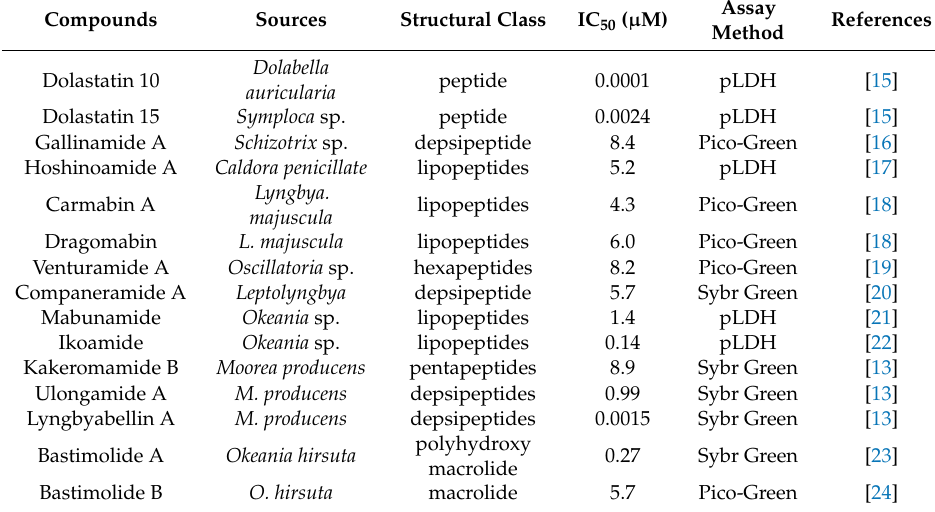
Table 1. Structural diversity and antimalarial potential of secondary metabolites derived from